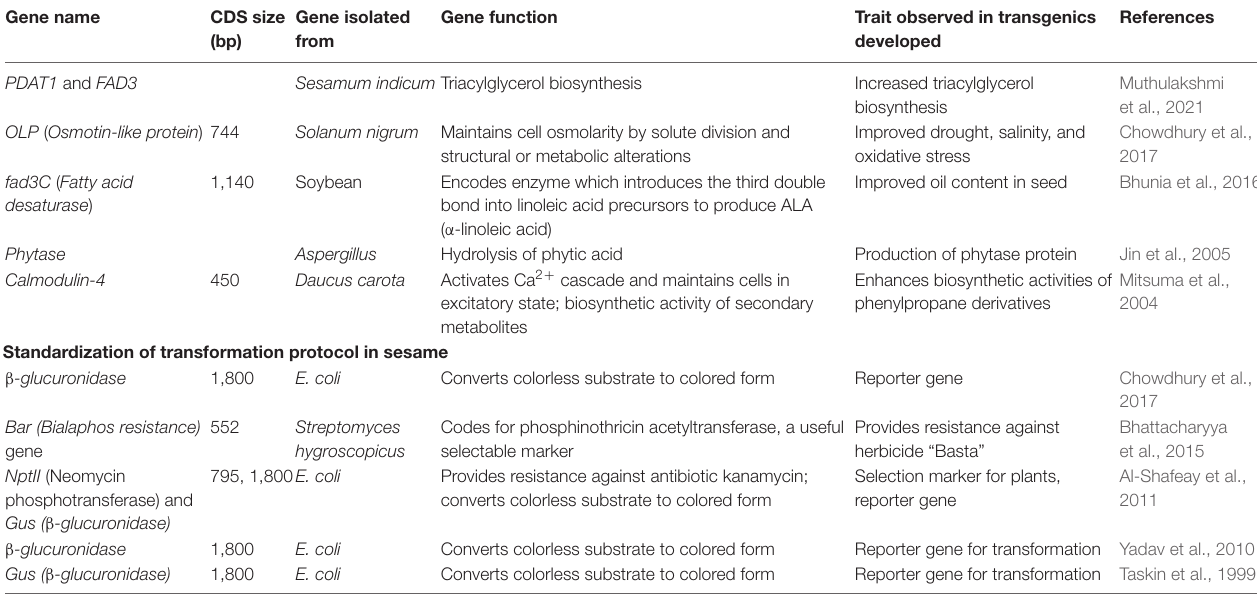
TABLE 10 | List of transgenic sesame developed for different